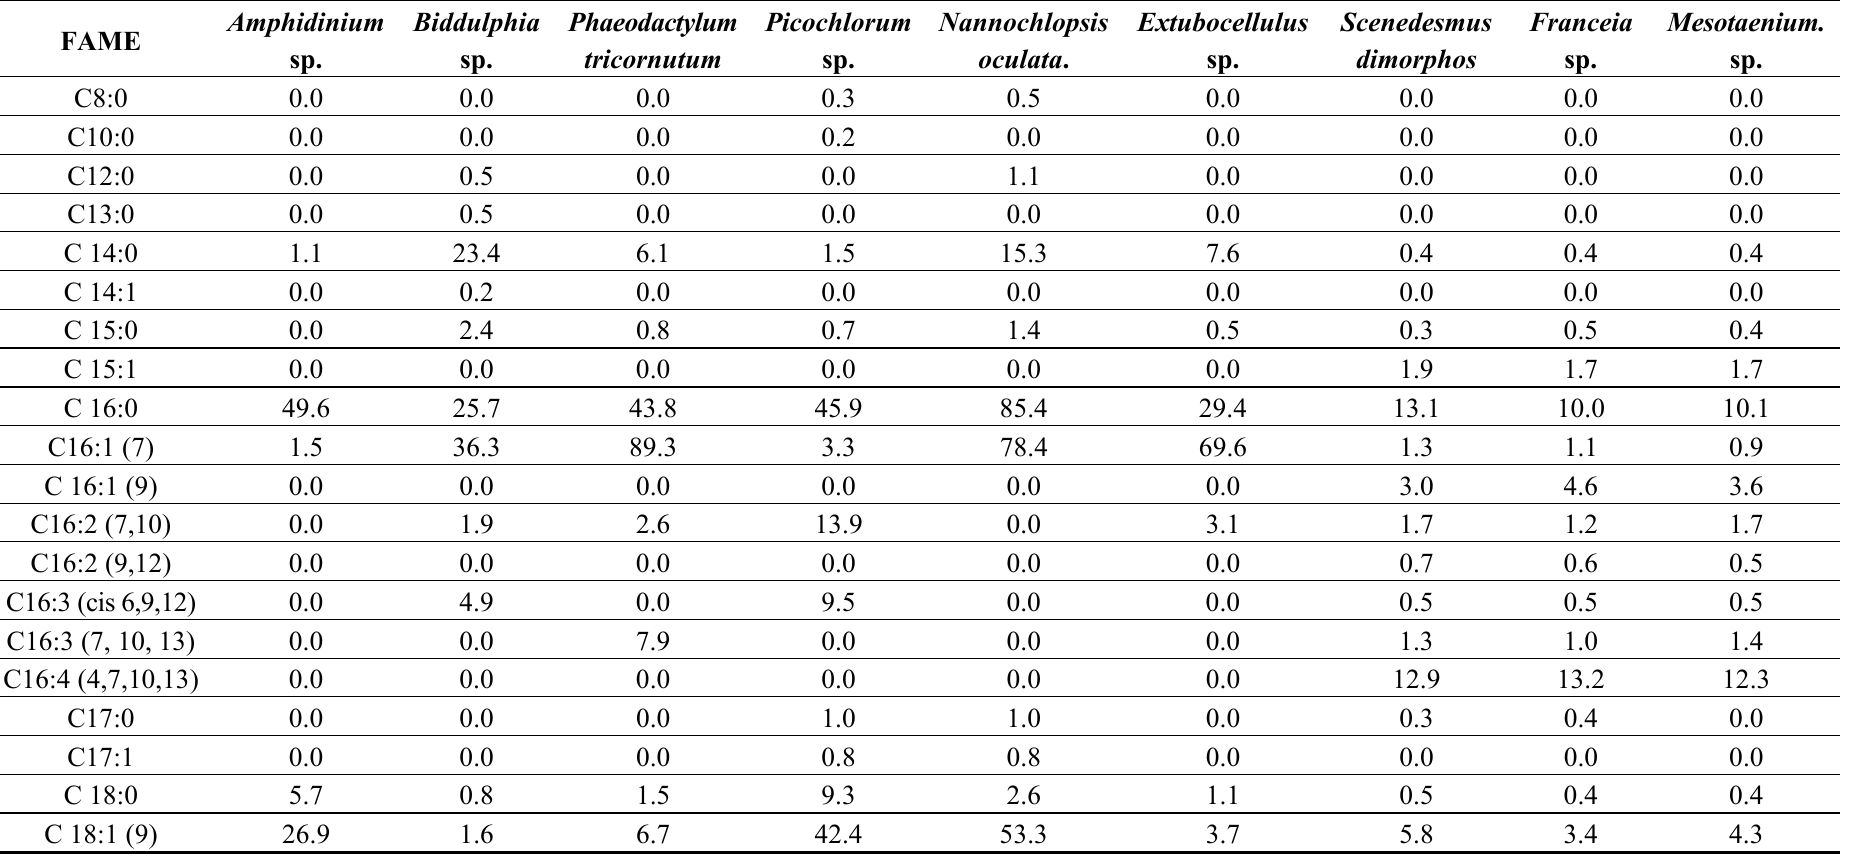
Table 2. Fatty acid methyl ester (FAME) profile of nine microalgal species (mg g − 1 of dry biomass) (this